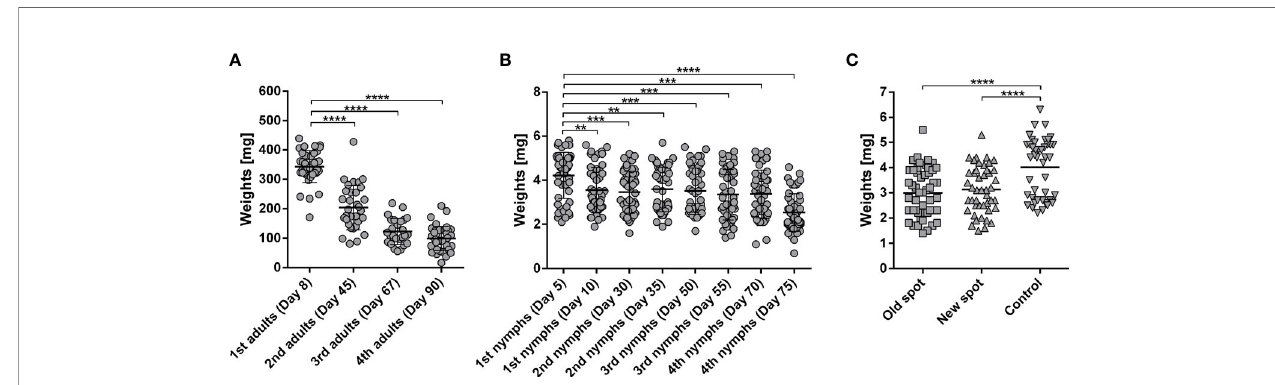
FIGURE 1 | (A) Weights of Ixodes ricinus adults repeatedly fed on one rabbit. I. ricinus adult females were fed on a laboratory rabbit in subsequent feedings with 2 – 3-week intervals between feedings. Adult females were placed in two chambers on opposing sides of the rabbit (25 ticks into each chamber); n ≥ 30; Days